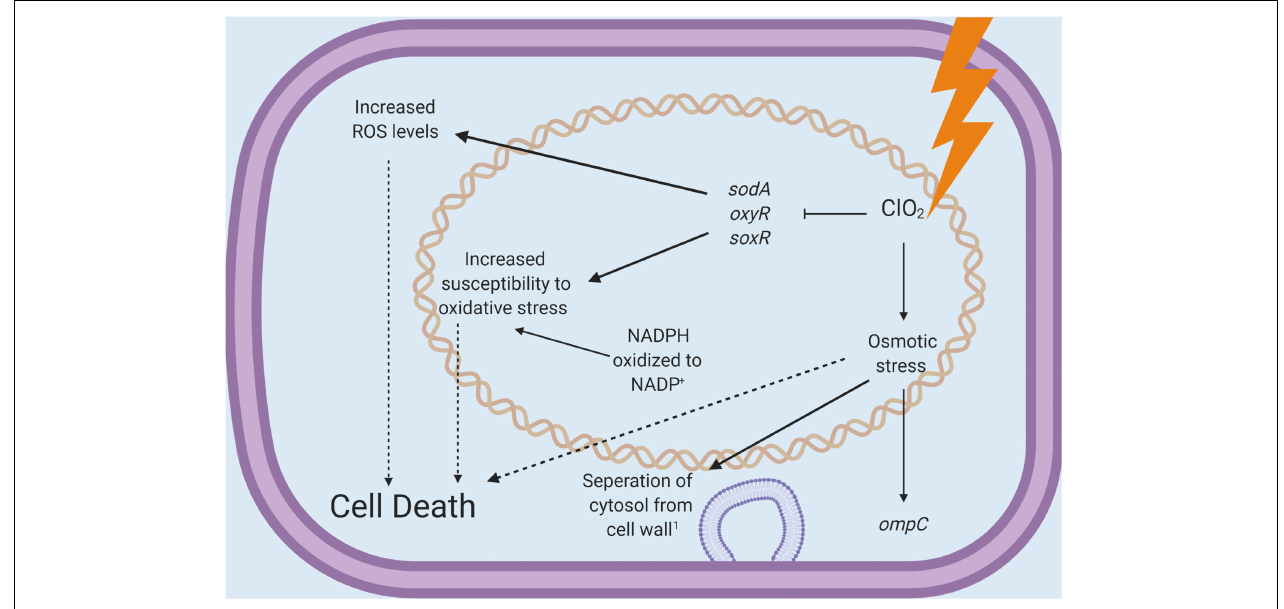
FIGURE 5 | A schematic diagram for the antibacterial mechanisms of chlorine dioxide concluded from the present study.